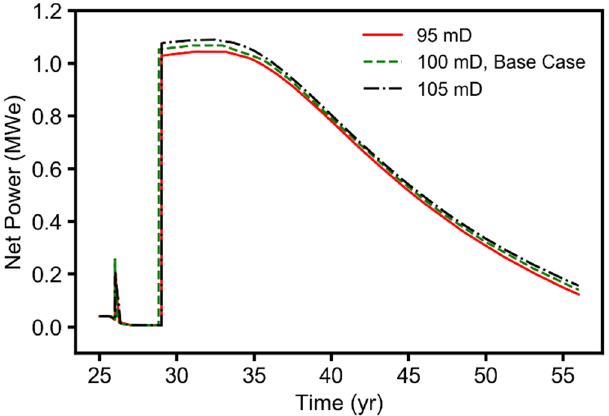
Figure A2. Simulation results (time-series plots) for the four reservoir model example cases, showing the net geothermal power generated during the EGR and CPG stages (25/26–55/56 years).